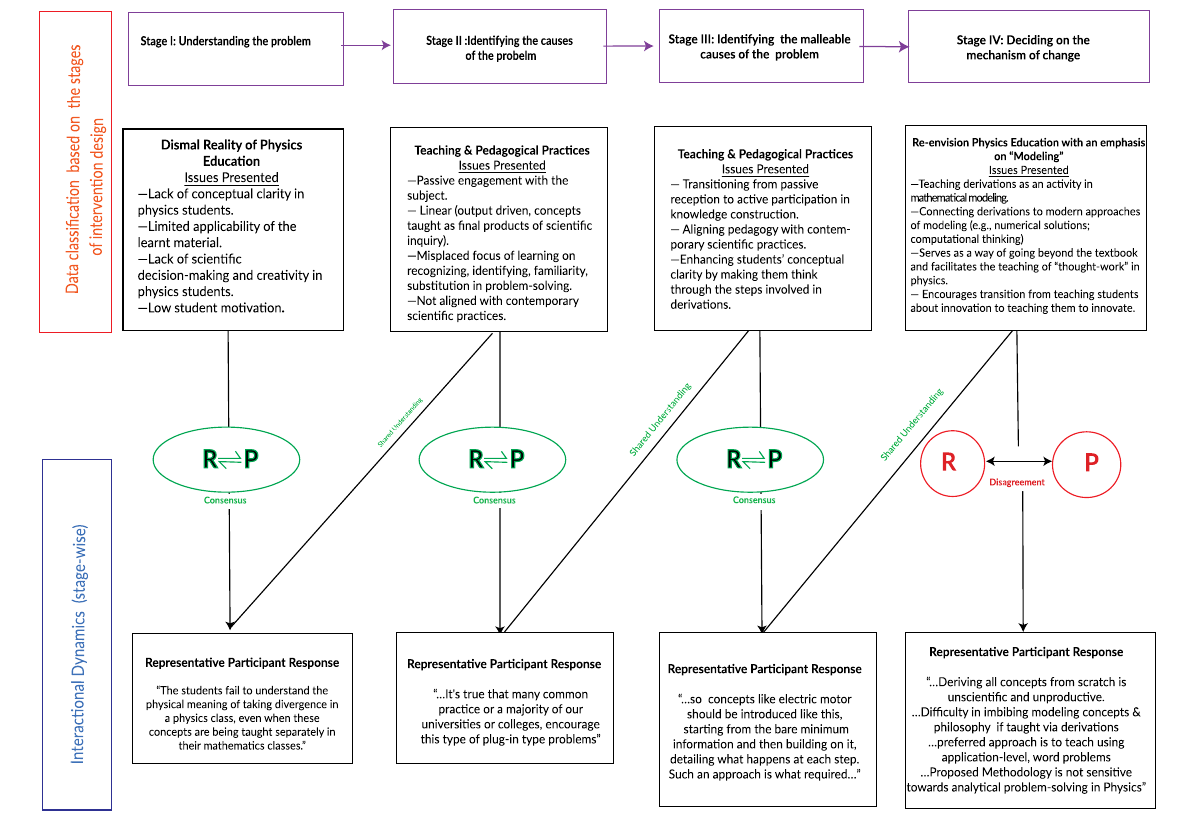
FIG. 8. An overview of teacher participants ’ and researchers ’ conflicting and accordant opinions about the